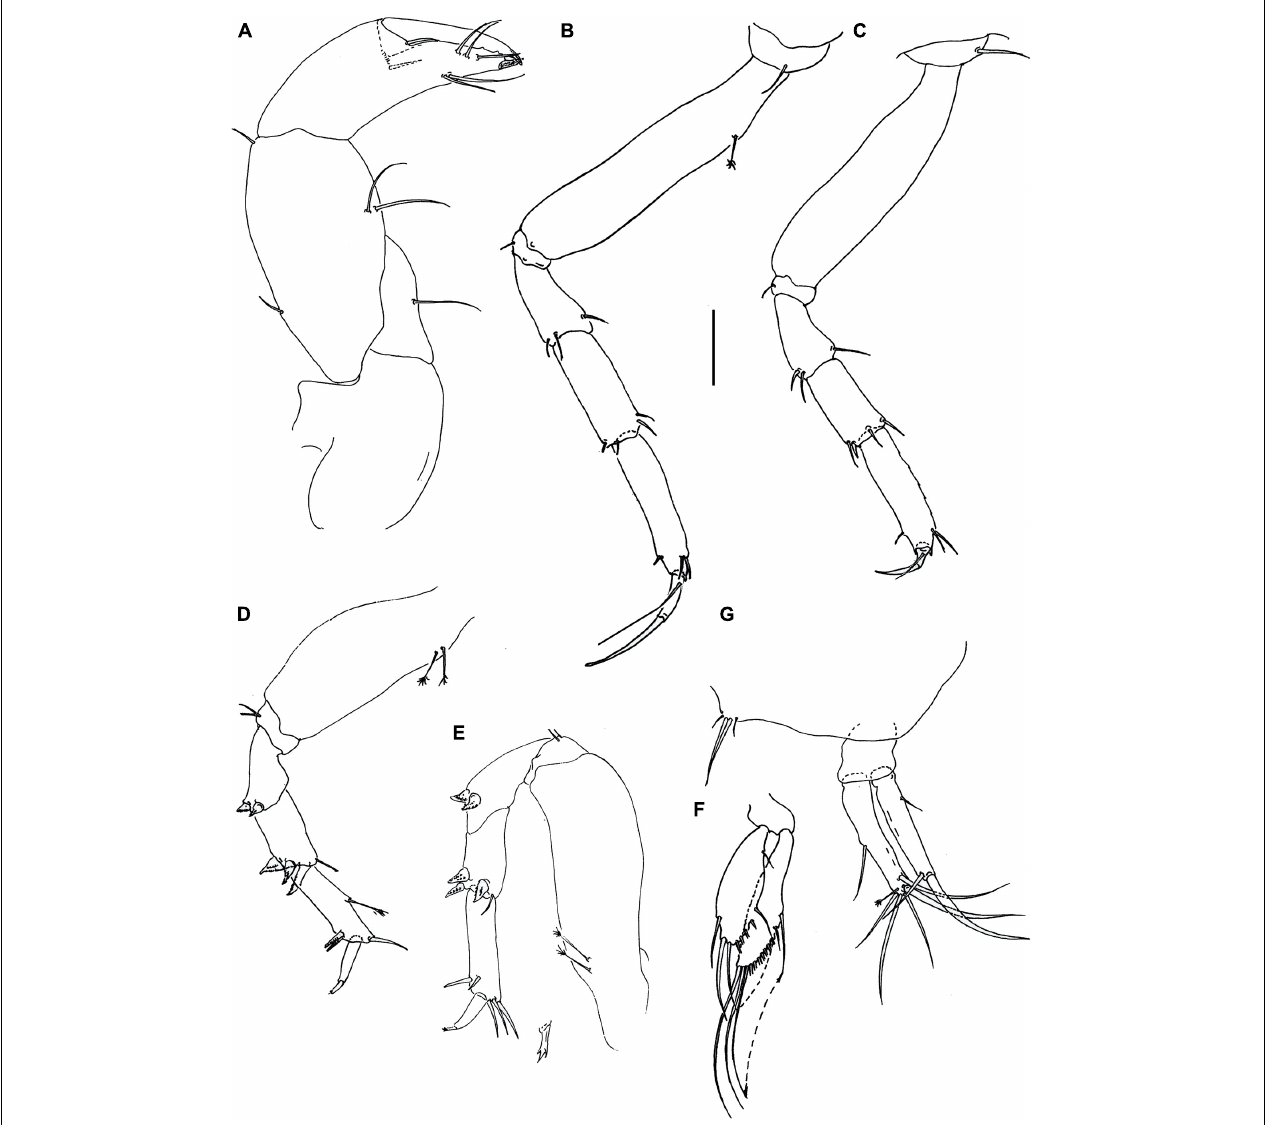
FIGURE 10 | Hamatipeda lelibi n. sp. (J57937) (A) cheliped; (B) pereopod-1; (C) pereopod-2; (D) pereopod-4; (E) pereopod-6; (F) pleopod; (G) uropod. Scale: panels (A–G) = 0.1 mm.